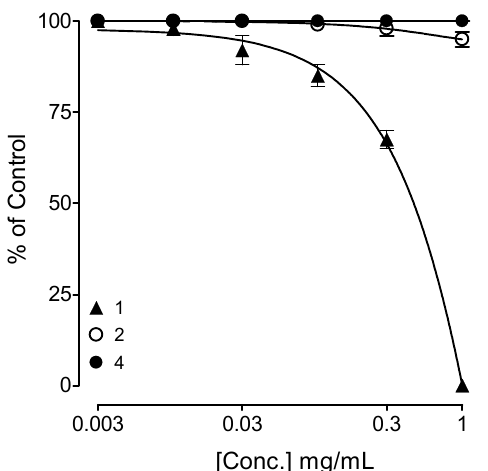
Figure 4. Concentration–response curves showing the comparison of the tracheal relaxation of compounds ( 1 ), ( 2 ) and ( 4 ) against carbachol (CCh; 1 µ M)-induced bronchoconstriction in guinea pig tracheal strip preparations. Results are expressed as mean ± SEM, n = 4.